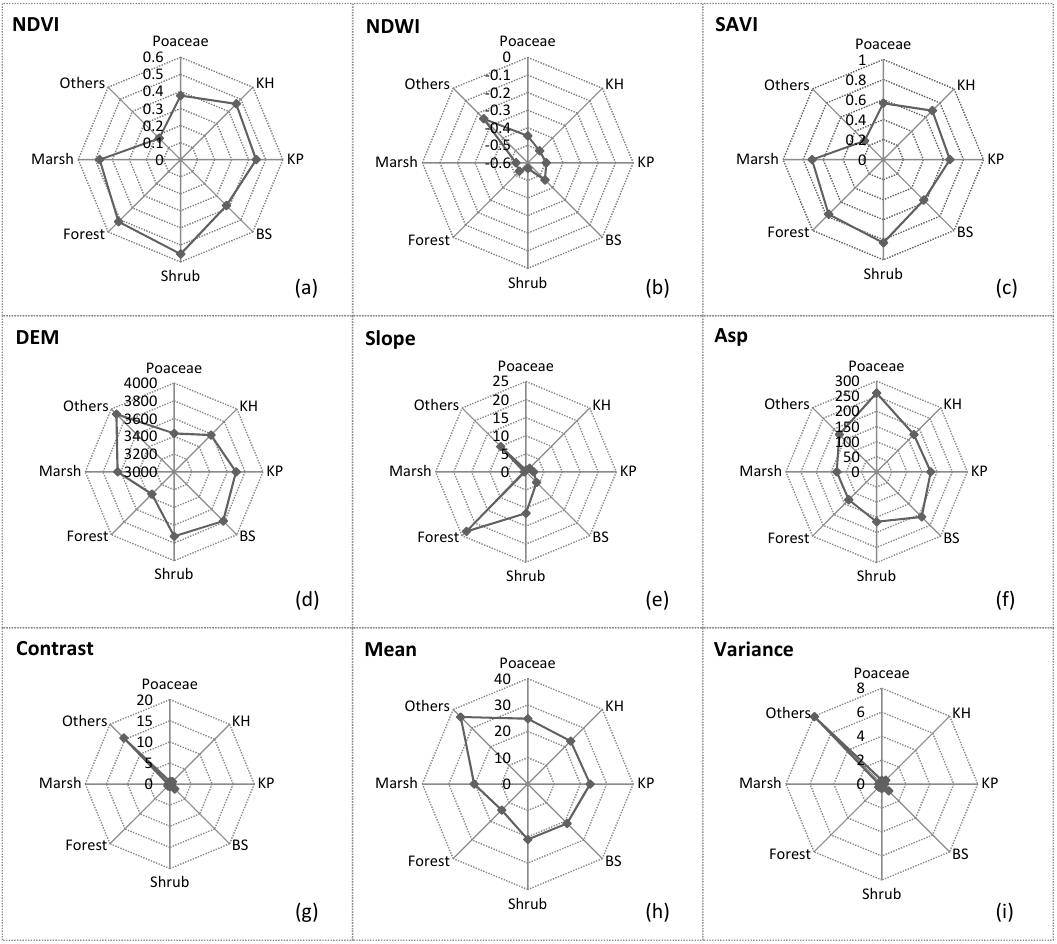
Figure 6. Characteristics of RS indices (a, b and c), topography (d, e and f) and texture metrics (g, h and i) in eight types of land covers: Poaceae, KH, KP and BS represent Elymus nutans + Stipa silena + Festuca ovina, Kobresia humilis, Kobresia pygmaea and black soil type, respectively.